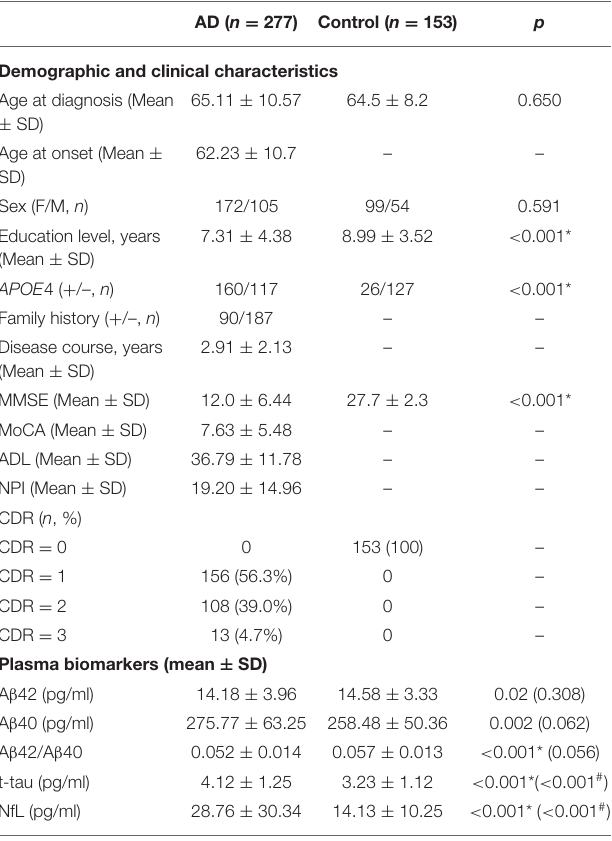
TABLE 1 | Demographic and clinical characteristics of patients with probable AD and healthy controls. AD ( n = 277) Control ( n = 153)